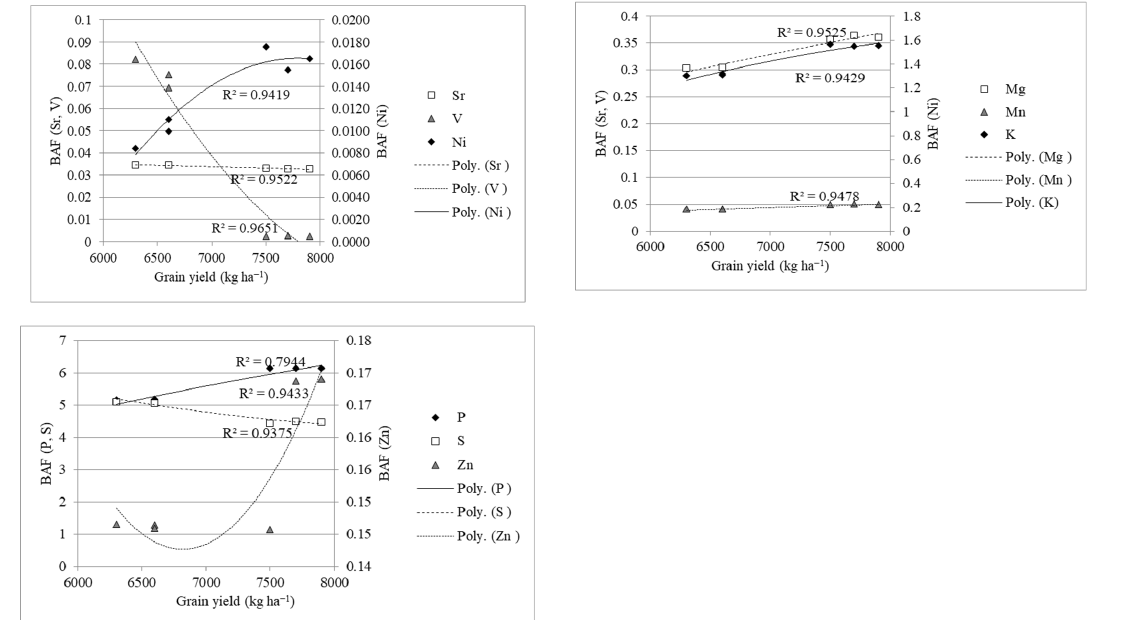
Figure A1. Interdependence (regression analysis) between grain yield and bioaccumulation factor (BAF) in wheat grain from intensive cropping system (ICS).